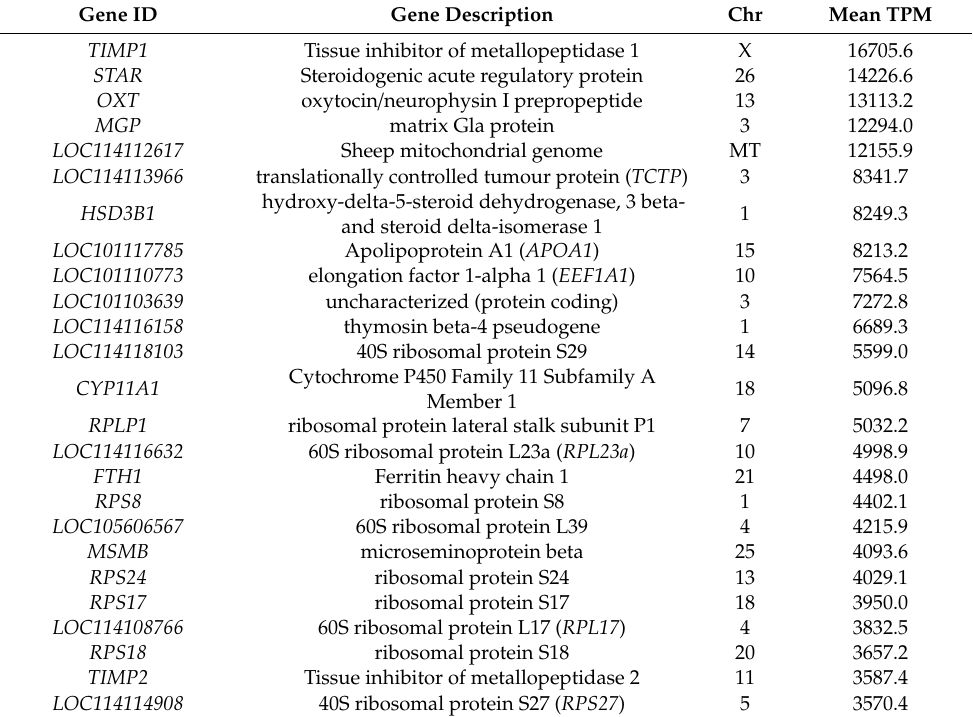
Table 3. List of top 25 most abundant genes expressed in the CL. Gene names and gene descriptions for gene IDs starting with “LOC” were retrieved from NCBI Genbank (https: // www.ncbi.nlm.nih. gov / genbank / ) and, GeneCards (https: // www.genecards.org / ), respectively. LOC114112617 marked originally as “uncharacterized ncRNA” in NCBI genbank, is indeed the mitochondrial genome of